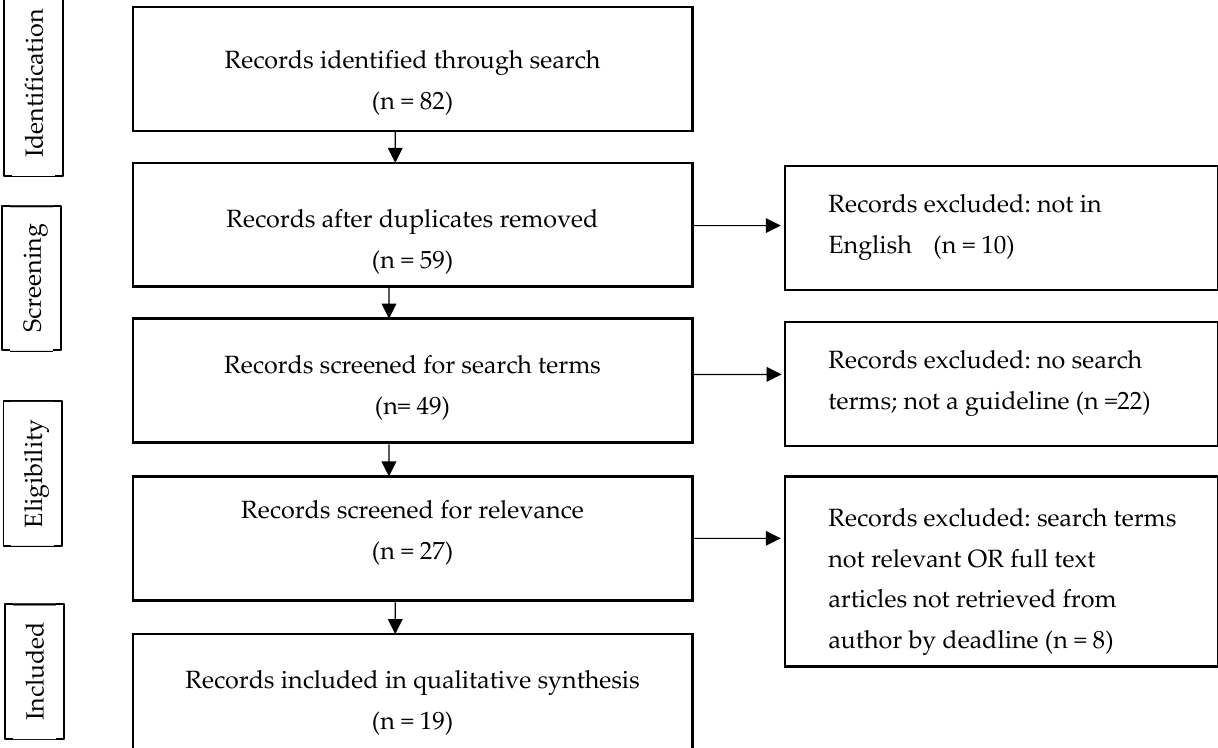
Figure 1. Flow chart for number of guidelines identified, screened, assessed for eligibility, and included in review.